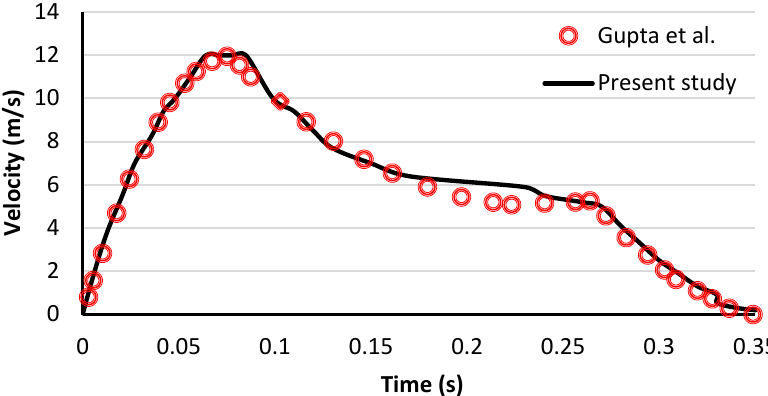
Figure 6. Air flow velocity of a single cough due to a pulse air jet as reported by Gupta et al.